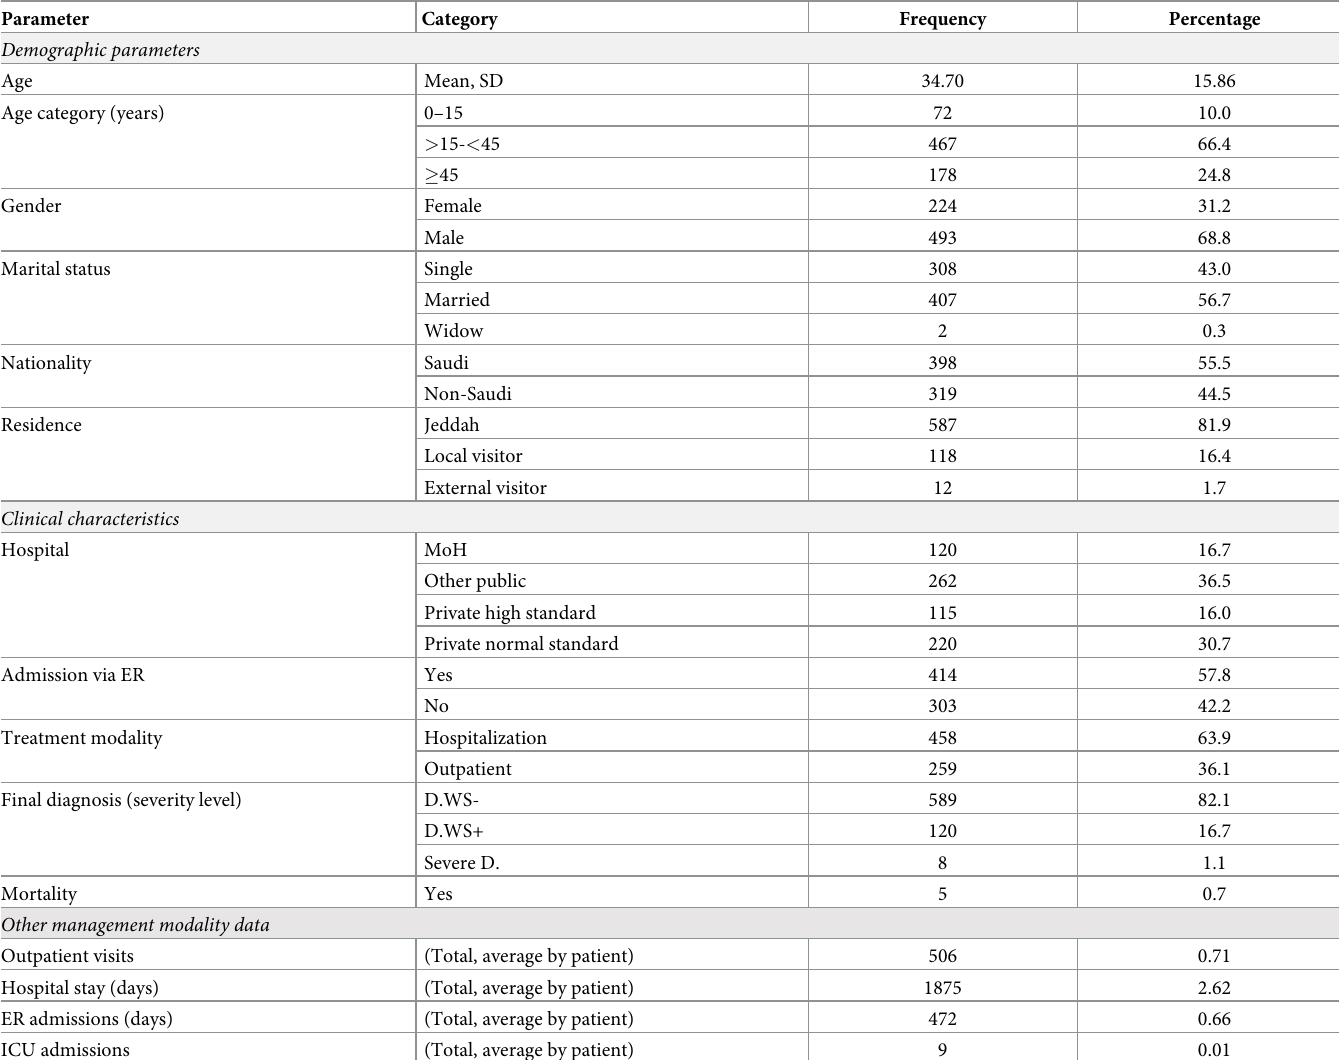
Table 2. Demographic and clinical characteristics of Source database patients (N =